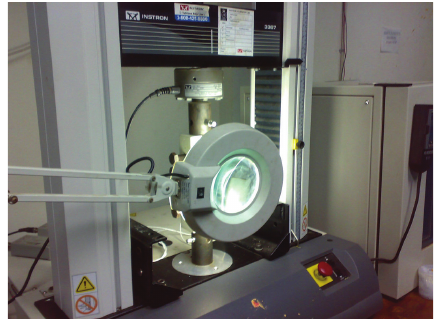
Figure 3: Magnifying lens for tracking